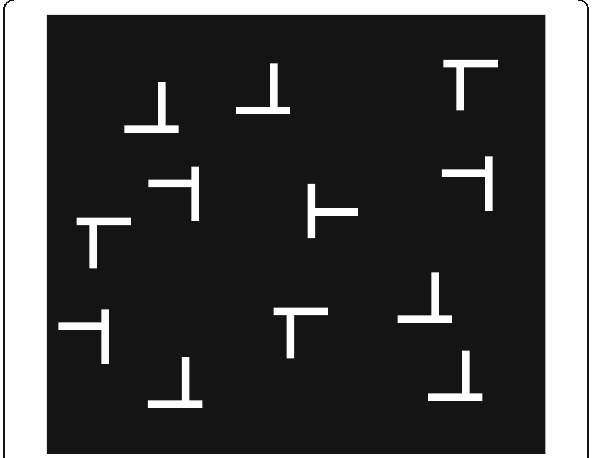
Fig. 4 Example display of experiment 2. In the single-feature condition the target T was red and the distracter Ls were green. In the spatial configuration condition all stimuli were white